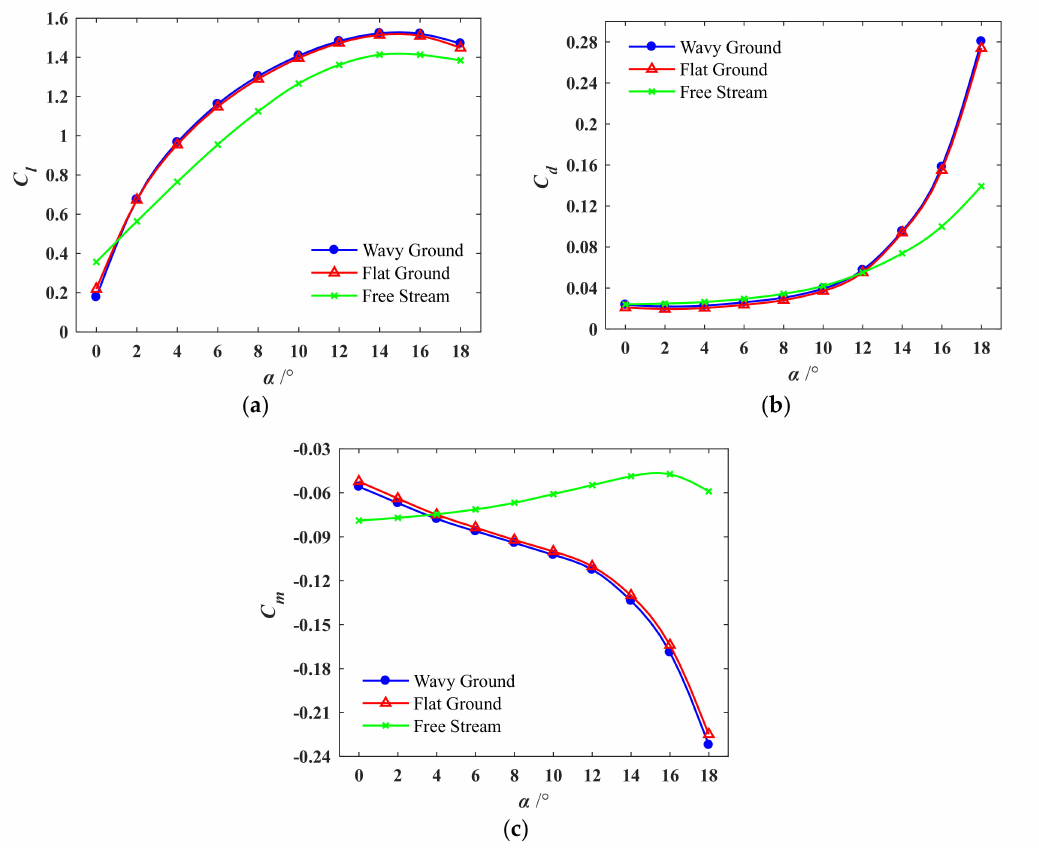
Figure 8. Variation in the time-averaged aerodynamics with the angle of attack: ( a ) lift coe ffi cient, ( b ) drag coe ffi cient, ( c ) moment coe ffi